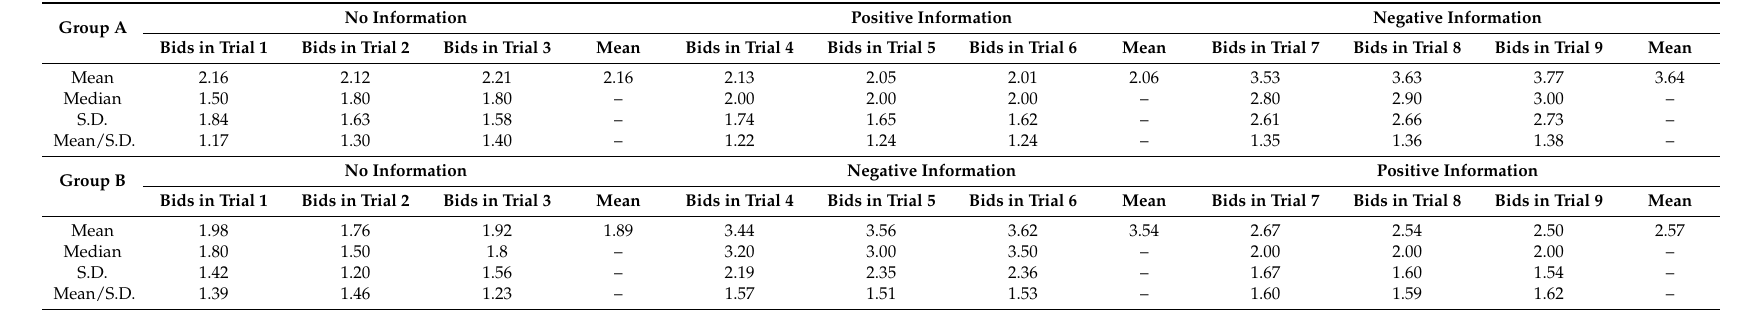
Table 6. Mean bids by trial for Group A and Group